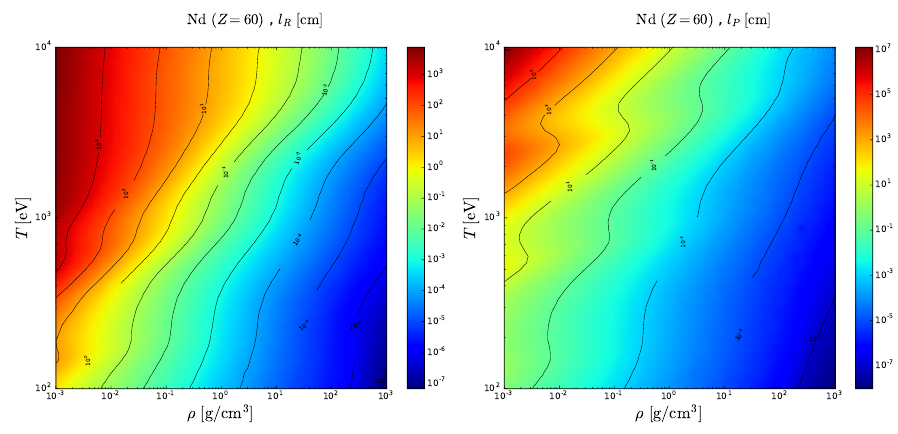
Figure 6. Same as Figure 5, for neodymium.